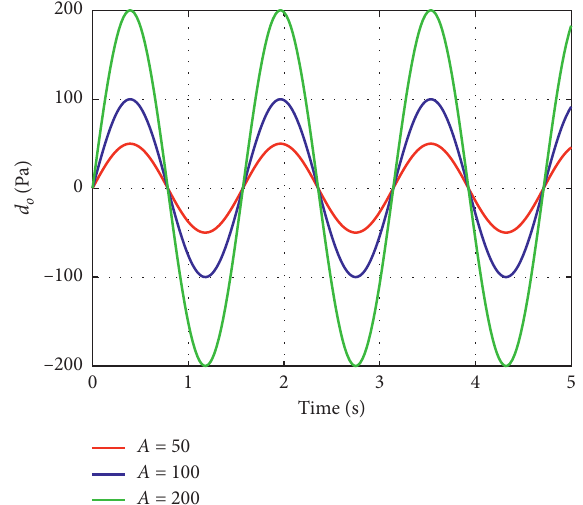
Figure 17: Different higher amplitudes of output disturbances d